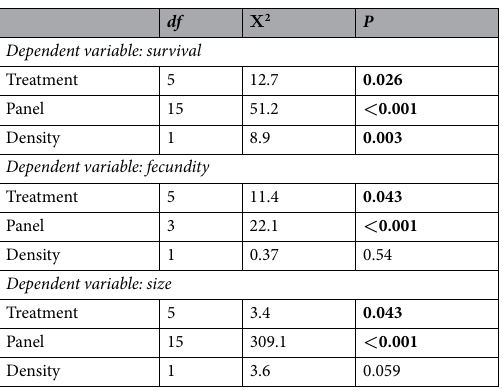
Table 2. Wald test results testing the effects of stressor treatment, panel, and density of conspecifics on survival, fecundity, and size. P-values below 0.05 are highlighted by bold